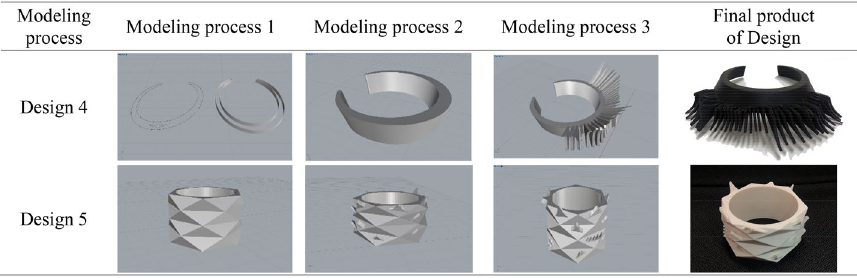
Table 9 Modeling process of ‘Design 4’ & ‘Design